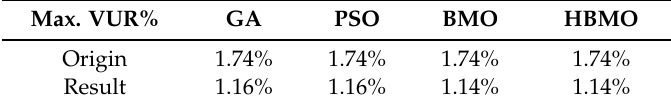
Table 1. Comparison of algorithms considering the Max. voltage imbalance ratio as the single objective.